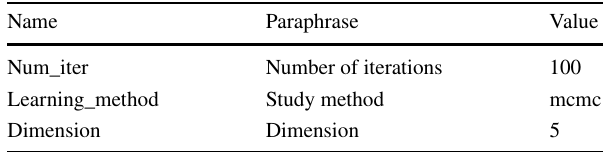
Table 3 The parameters of FM model